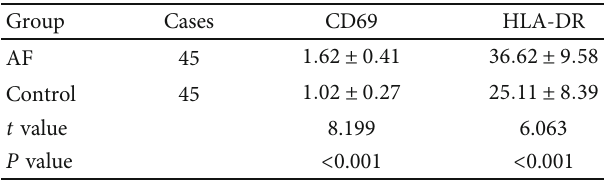
Table 2: The expression changes of CD69 and HLA-DR on CD3+ T lymphocytes in external blood of two groups ð x ± s Þ .